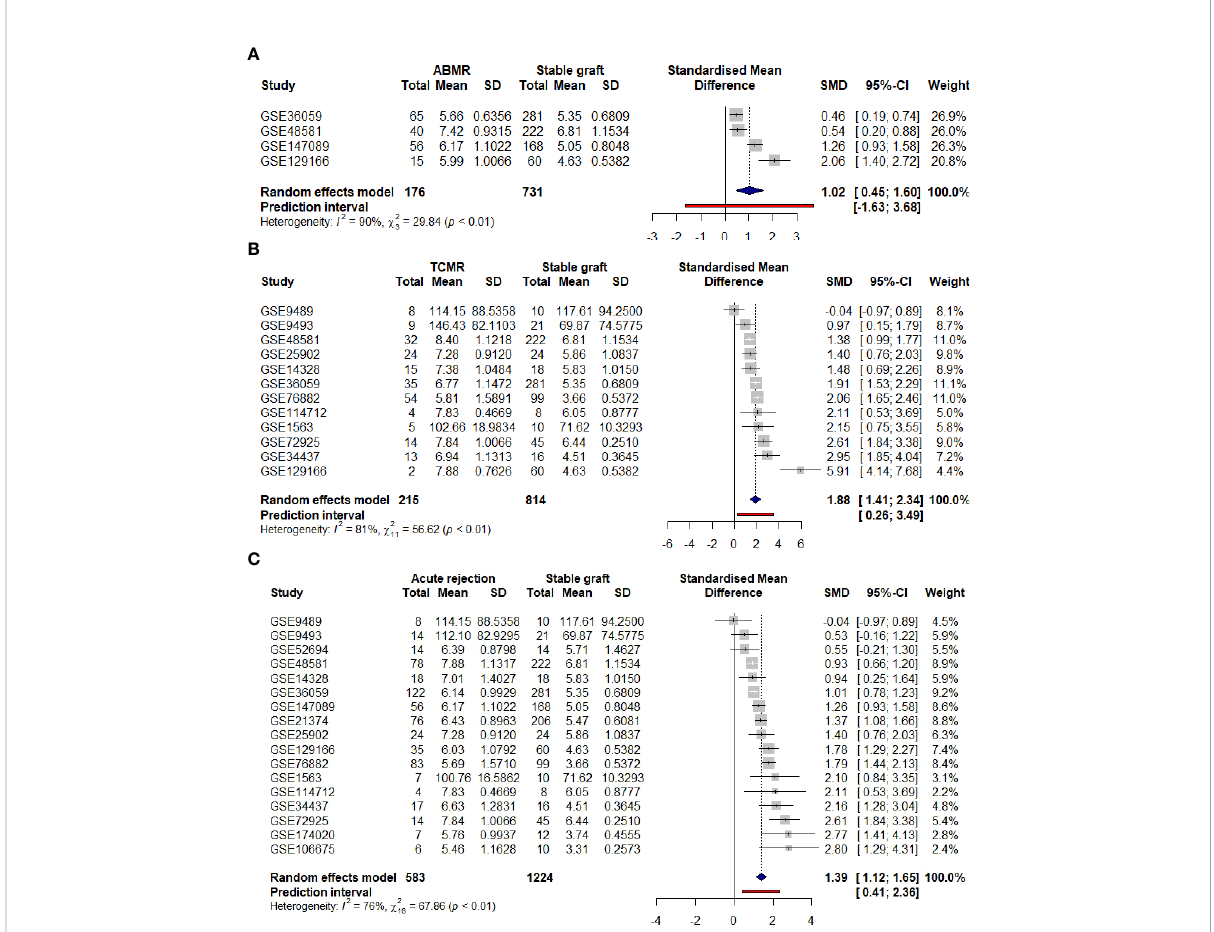
FIGURE 7 Clinical meta-analysis for AIM2 employing a random-effects model. Lines correspond to 95% con fi dence intervals. Square size is proportional to study weight on overall effect. Right axis indicates AIM2 enhancement on acute rejection, while left axis indicates an elevation of stable graft. (A) General comparison considering all acute rejections and stable graft samples. (B) Subgroup analysis of the 11 TCMR-only grafts. (C) Subgroup analysis of the four ABMR-only grafts. TCMR, T cell-mediated rejection; ABMR, antibody-mediated